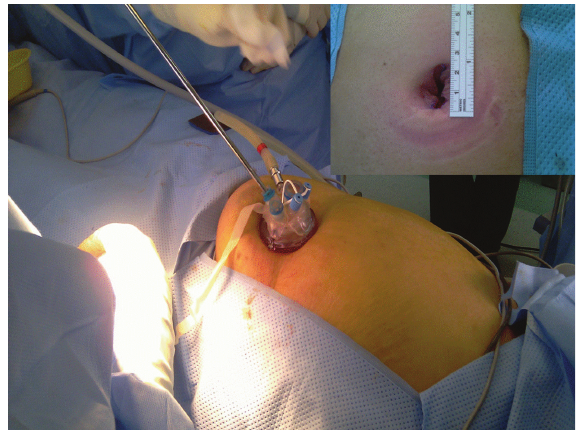
Figure 1: Operative placement of umbilical TriPort. In the small corners, the size of the skin incision does not exceed